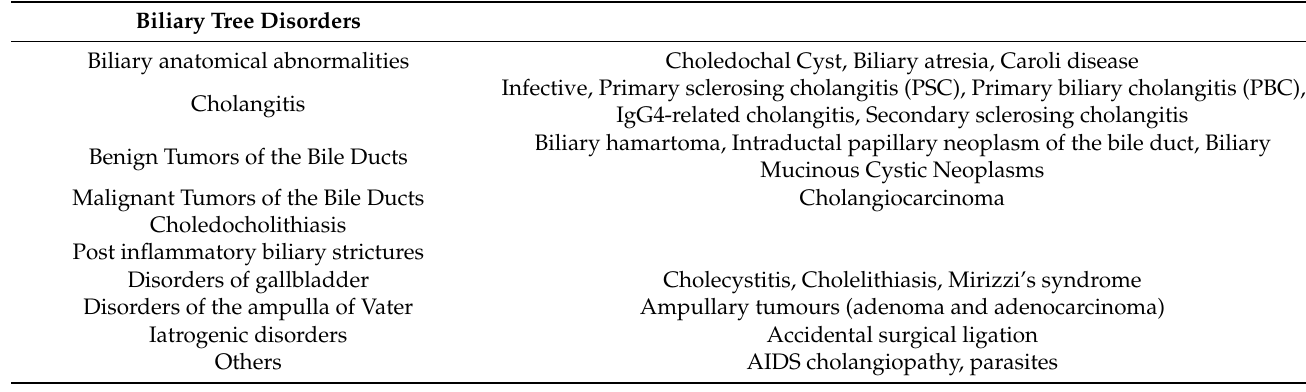
Table 1. List of biliary tree disorders commonly found in clinical practice.